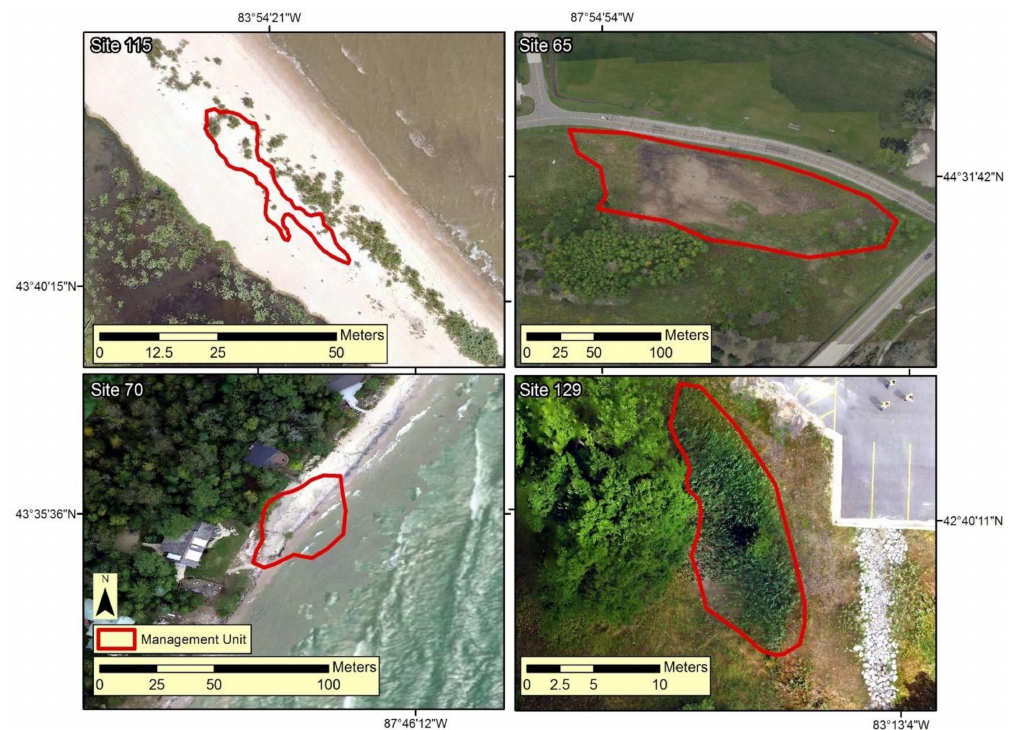
Figure 8. Overview images of four UAV collection sites. Site 115 has been covered by a retreating beach due to rising water levels in the Great Lakes; site 65 has received Phragmites removal treatment; site 70 is now partly underwater due to rising water levels; site 129 was enrolled in PAMF but did not receive any treatment to reduce Phragmites extent.